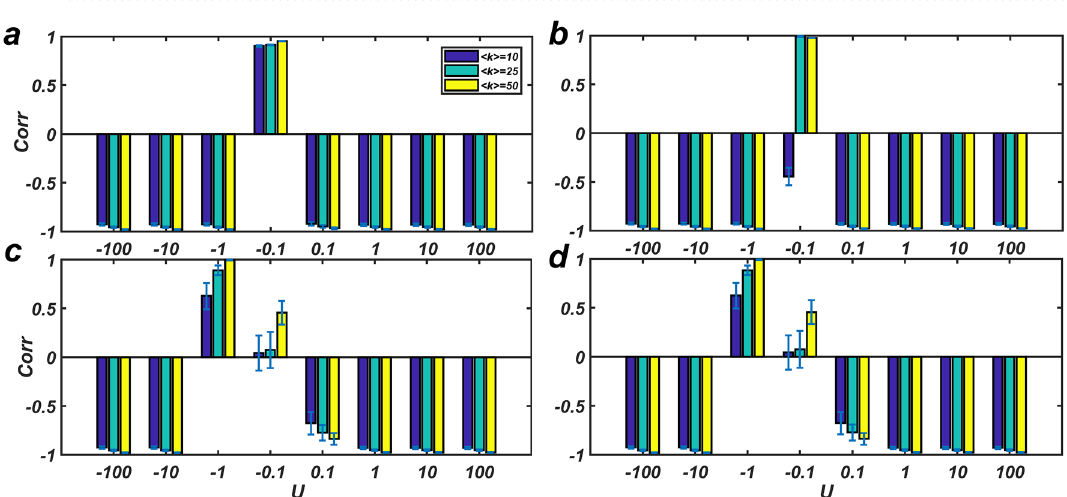
Figure 3. The correlation coefficient between f and g . In random networks with size 100 and different average degree 〈 k 〉 . The Absolute value of correlation coefficient is high in all cases except in cases when the value of the input signal is very small. U = − 100, − 10, − 1, − 0.1, 0.1, 1, 10, 100 are the input signal. The input signal is applied to all nodes ( a) in 5 Consecutive steps, ( b) in 20 Consecutive steps, ( c) Single signal applied to the whole nodes with m = 5, and ( d) Single signal applied to the whole nodes and m = 20 . The graphs show the average value with bars corresponding to the standard deviation over 20